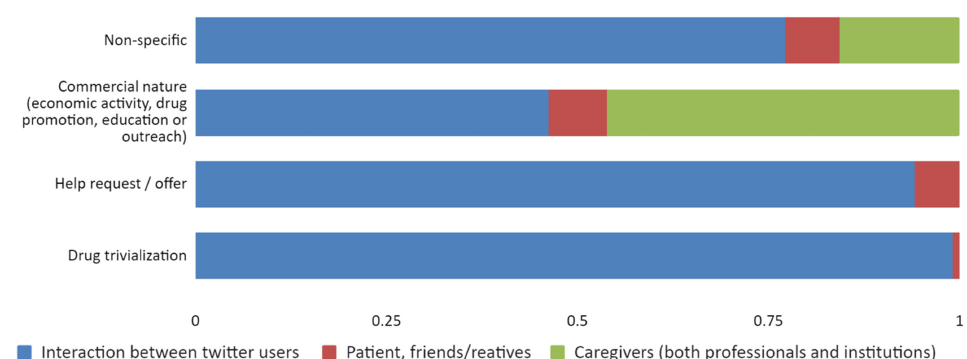
Figure 3. Proportion of type of user by area of clinical interest.